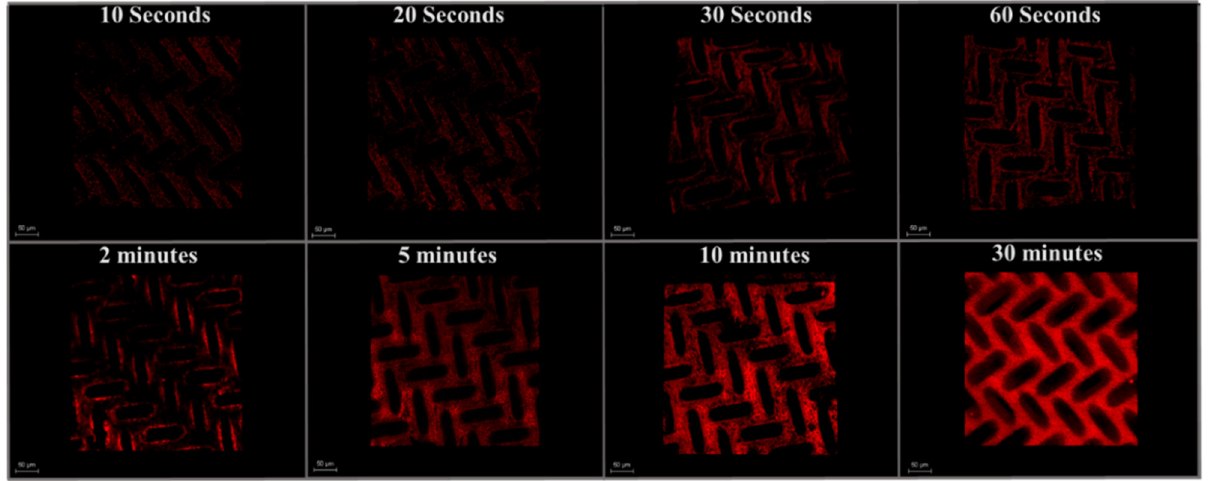
Figure 7. Fouling profile images of (BSA) at eight filtration times on the surface of a patterned membrane. Scale bar is 50 μ m.